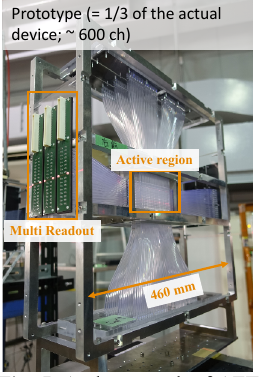
Fig. 5. A photograph of AFT- proto2 tested at ELPH, Tohoku University in